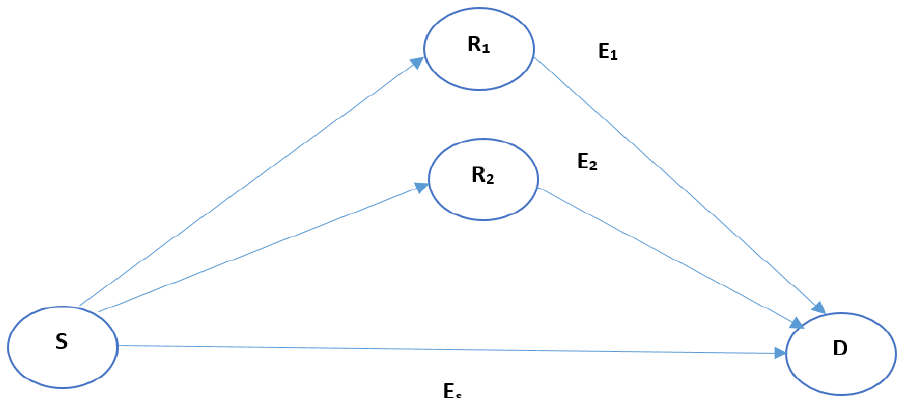
Figure 2. Downlink energy harvesting (EH) Cooperative Relaying Model with best relay selection (BRS)